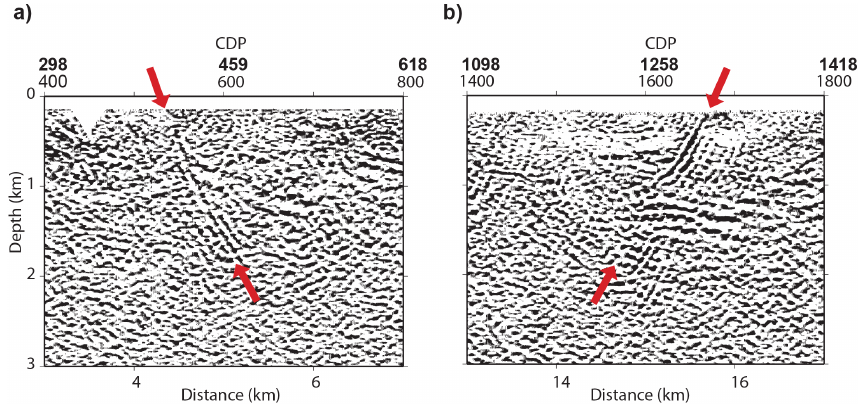
Figure 7. The re-migrated sections of the previous seismic survey (Juhlin et al., 2010) with the velocity model provided by Lindblom et al. (2015). (a) The image of the main Pärvie fault (R3); (b) the image of the west-dipping subsidiary fault (R1). The images show that the R1 and R3 faults (shown by the red arrows) dip at about 60 and 65 ◦ to the west and the east, respectively. CDP numbers from the new explosive survey are shown in bold. The vertical exaggeration is 1 ×